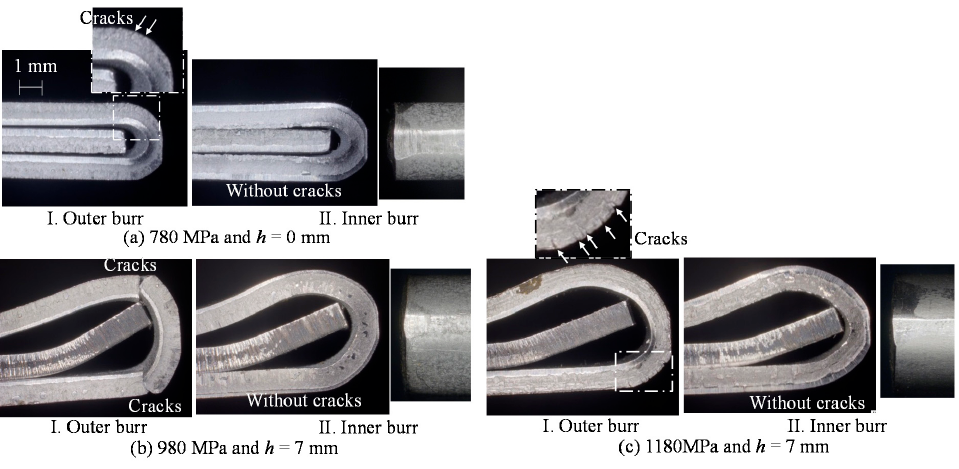
Figure 10. E ff ect of burr direction on cracks on sheet edge. Figure 10. Effect of burr direction on cracks on sheet edge. Figure 10. Effect of burr direction on cracks on sheet edge.